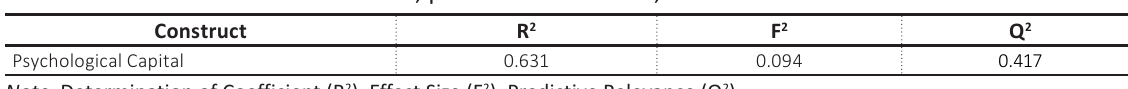
Table 4. Determination of coefficient, predictive relevance, and effect size